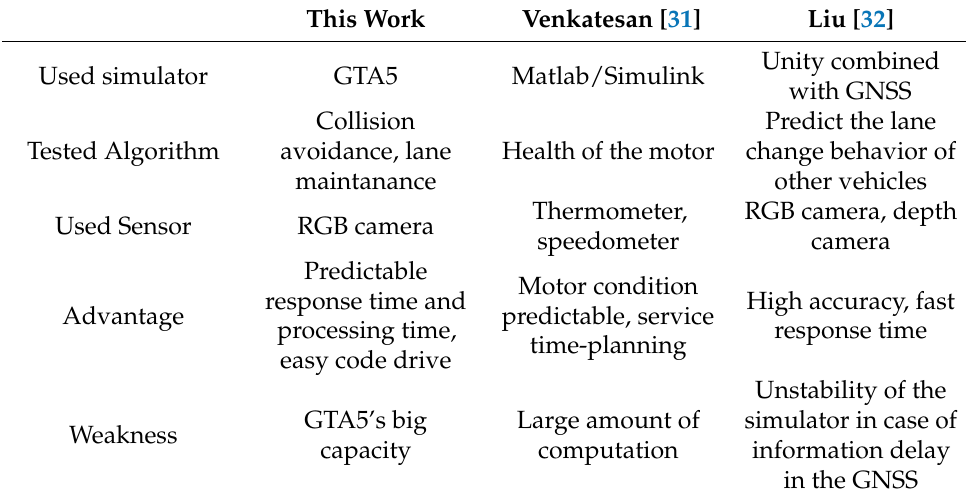
Table 1. Performance comparison with